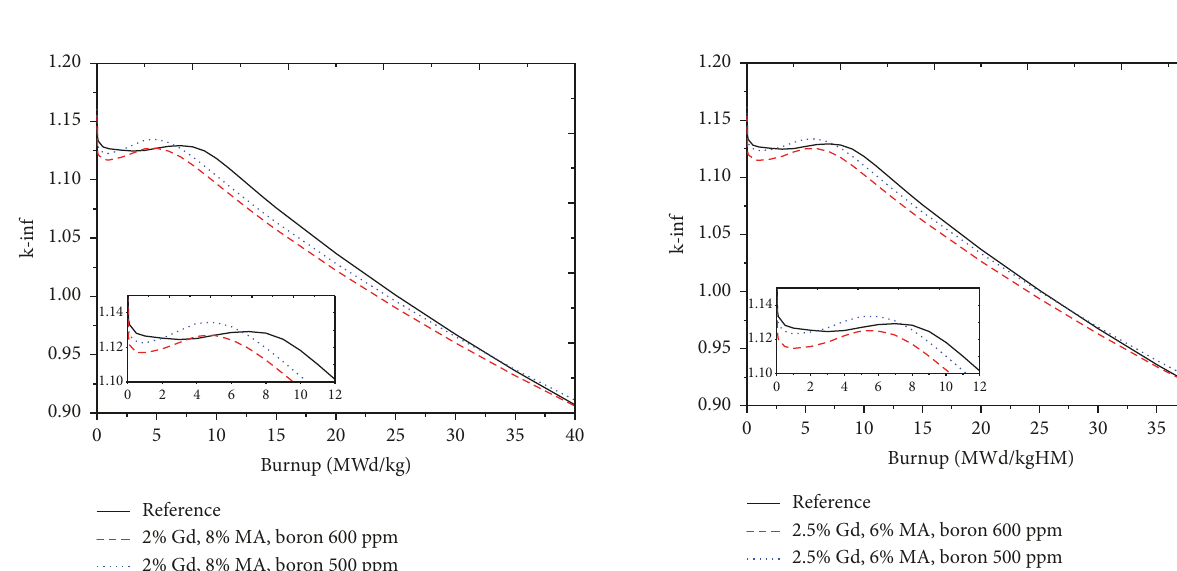
Figure 5: The k-inf versus burnup when loading 8wt.% of MAs and reducing GD to 2 wt.%.